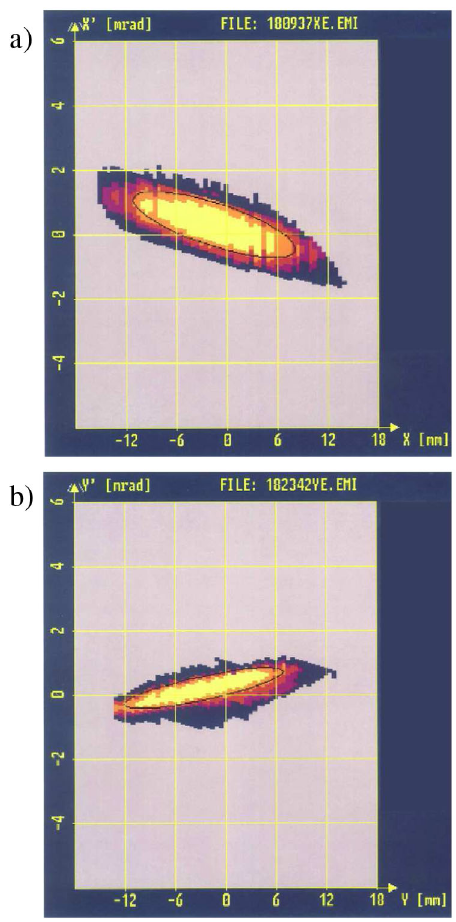
FIG. 1. Horizontal (a) and vertical (b) beam phase space measured in the transfer channel between UNILAC and